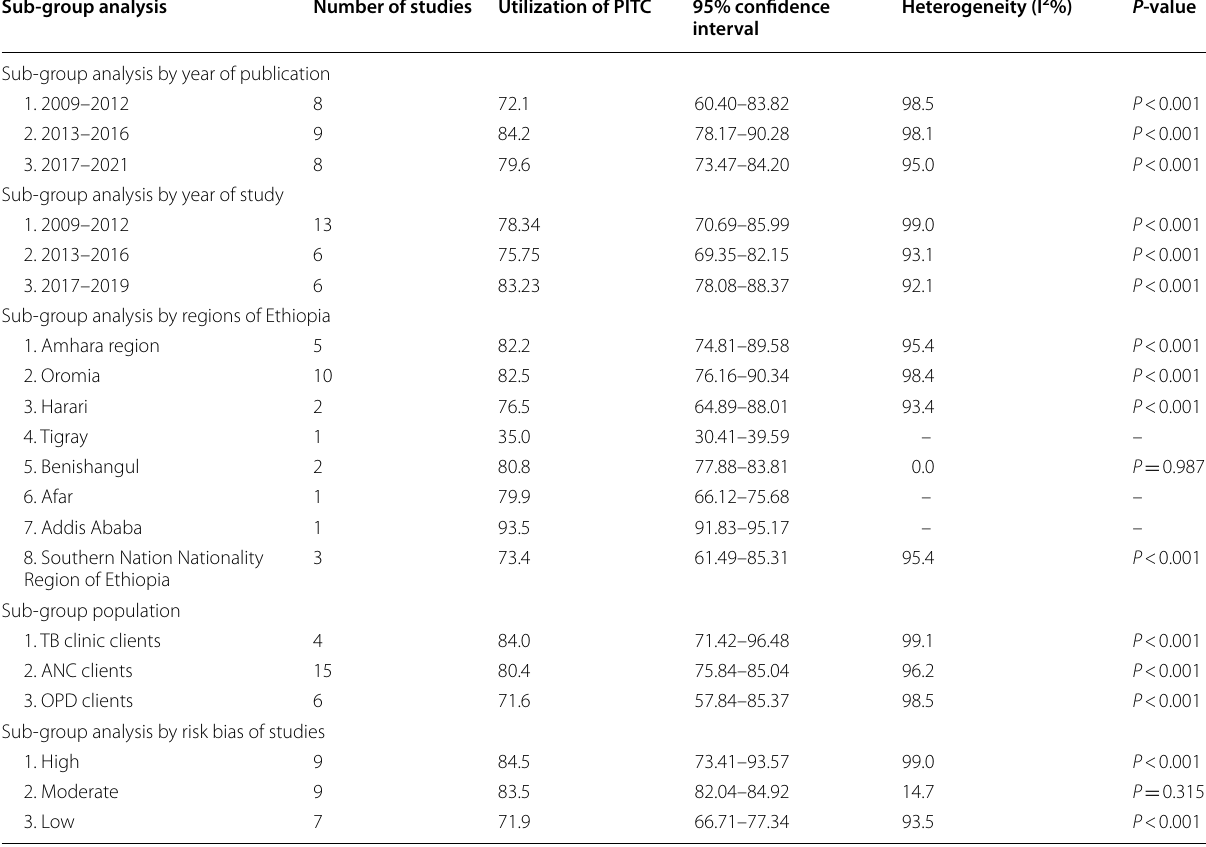
Table 2 Sub-group analysis by region, year of publication, year study, study population and risk of bias on pooled utilization of PITC in Ethiopia